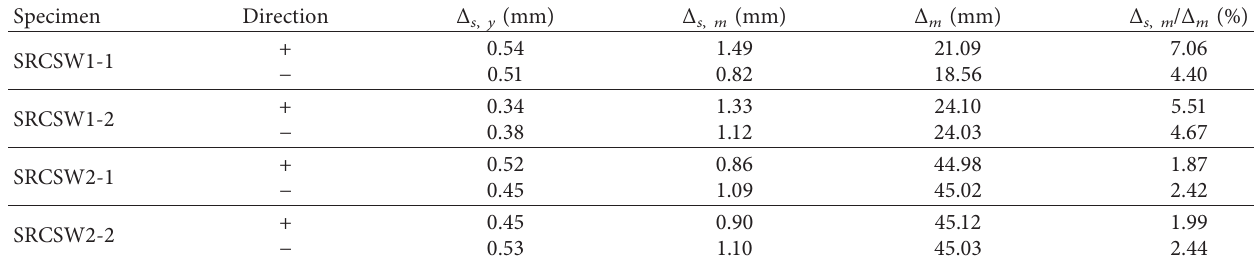
Table 4: Shear-slip displacement of wall-to-foundation area of the PC